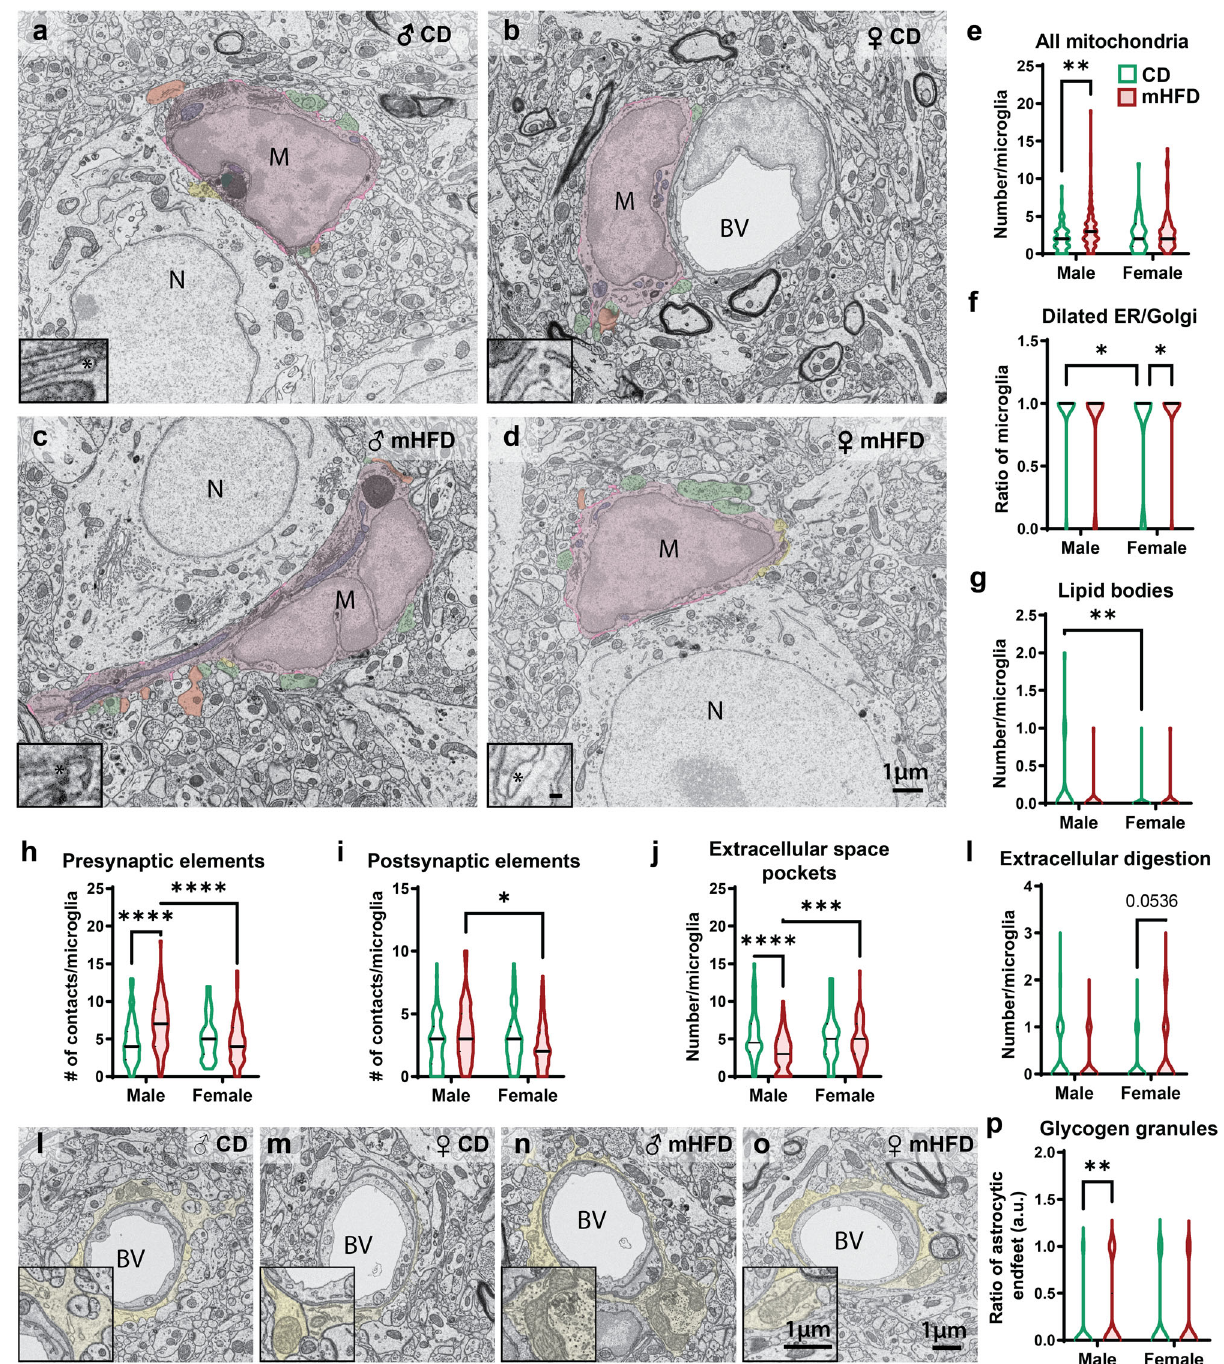
Fig. 3 Microglia and astrocytic endfeet are sexually dimorphically affected in P30 offspring exposed to mHFD. a – d Pictures illustrate ultrastrucutral changes of microglia (identi fi ed by “ M ” , pseudocoloured in fuchsia), where the insets show a higher magni fi cation on endoplasmic reticulum and/or Golgi apparatus cisternae in which the scale bar is equivalent to 100 nm (visible in panel d ). Changes were notably observed in ( e ) number of mitochondria (pseudocoulored in purple), ( f ) dilation of the endoplasmic reticulum and Golgi apparatus cisternae (identi fi ed by “ * ” ), and ( g ) lipid bodies (pseudocoloured in turquoise) of microglial cell bodies as well as their interactions with ( h ) presynaptic axon terminals (pseudocoloured in green), ( i ) postsynaptic dendritic spines (pseudocoloured in red), ( j ) extracellular space pockets (pseudocoloured in pink) and ( k ) extracellular digestion also known as exophagy (pseudocoloured in dark yellow). l – o Micrographs show representative astrocytic endfeet (pseudocoloured in yellow) for each offspring group, where mHFD-exposed male offspring have an ( p ) increased accumulation of glycogen granules. Violin graphs show minimum, median (line) and maximum (77 – 84 microglia/diet/sex, N = 4 animals/group for ultrastructure analysis of microglia; n = 93 – 95 capillaries/diet/sex for astrocytic glycogen granules analysis). * P < 0.05, ** P < 0.01 by mixed-effect analysis followed by Bonferroni post-hoc . ♀ : female, ♂ : male, a.u.: arbitrary unit, CD: control diet, mHFD: maternal high-fat